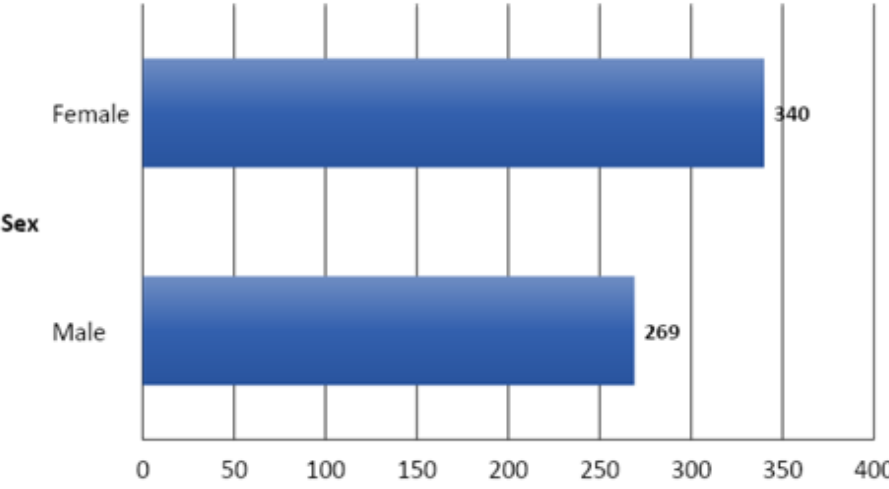
Figure 10. Distribution of lesions according to the sex of the animals.